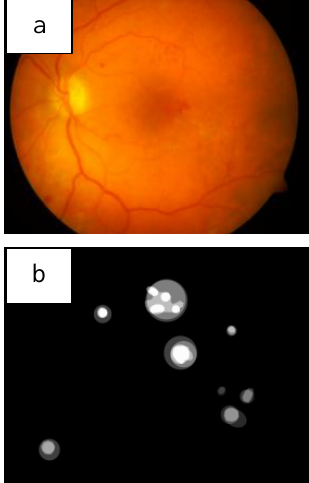
Fig. 1. The examples of: (a) RGB original image; (b) ground truth image